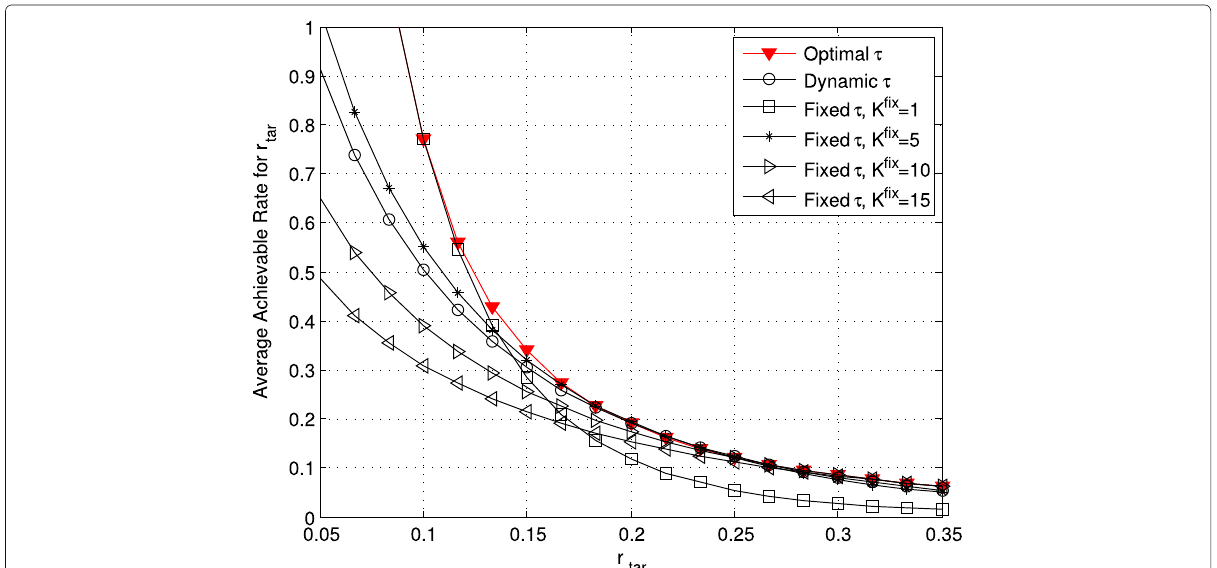
Fig. 6 Average achievable rate for varying target distance with the different SA-AC schemes when T d ( dB ) = − 10 and T u ( dB ) = 0. As in Fig. 5, the proposed SA-AC scheme with the optimal TP is shown to be the